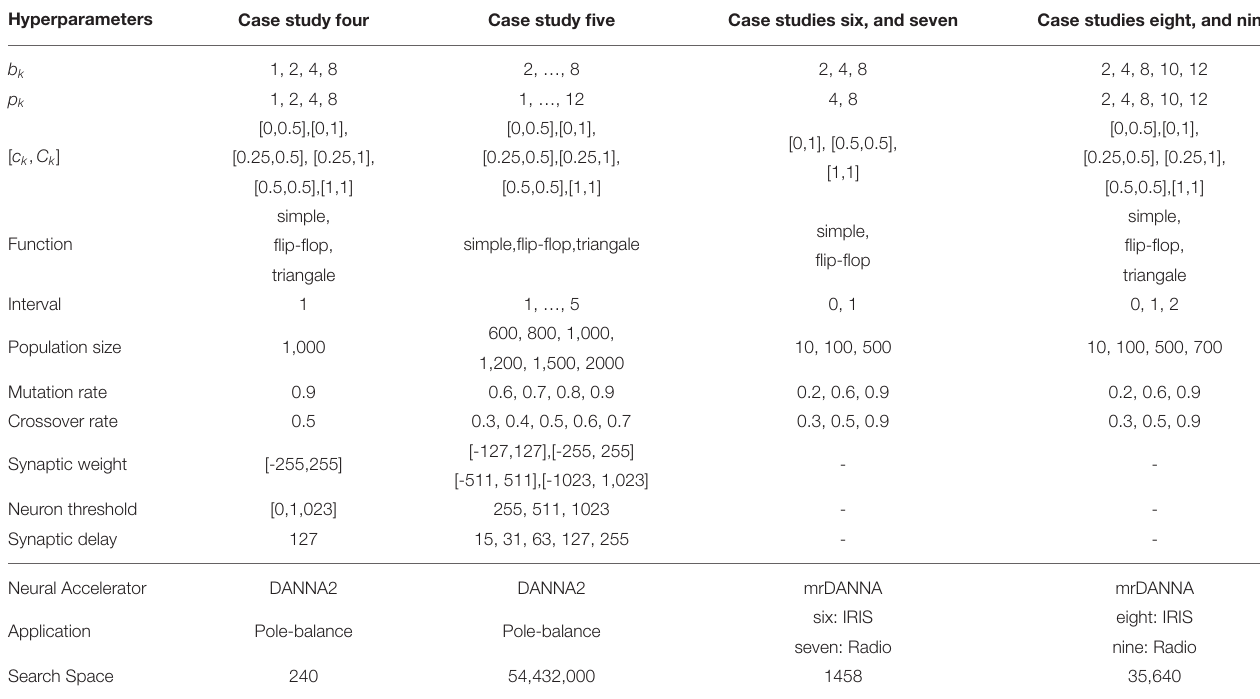
TABLE 4 | Evaluated parameters for case studies four to nine for